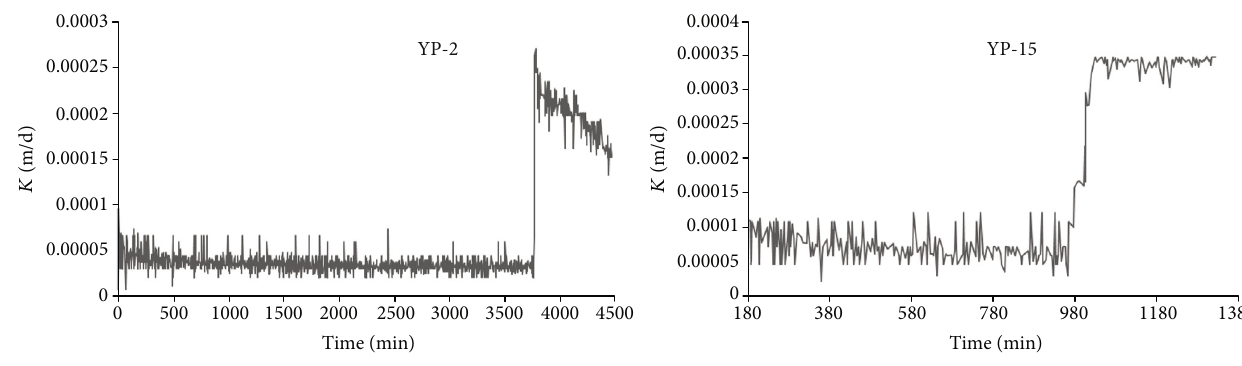
Figure 7: The hydraulic conductivity curves of YP-2 and YP-15. Table 5: The hydraulic conductivity of samples YP-2, YP-15, and YP-21 before and after the change.